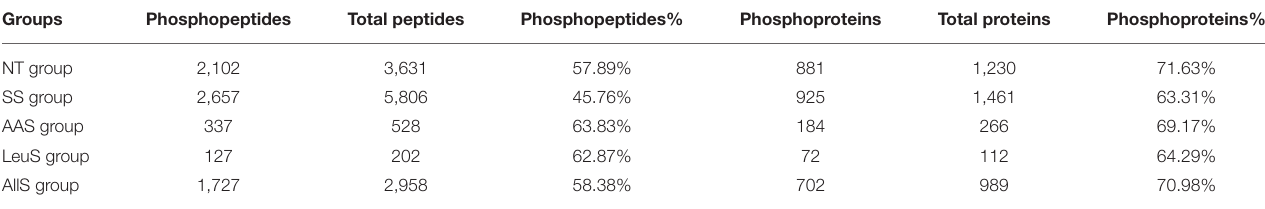
TABLE 1 | The composition and number of identified petides and proteins. Groups